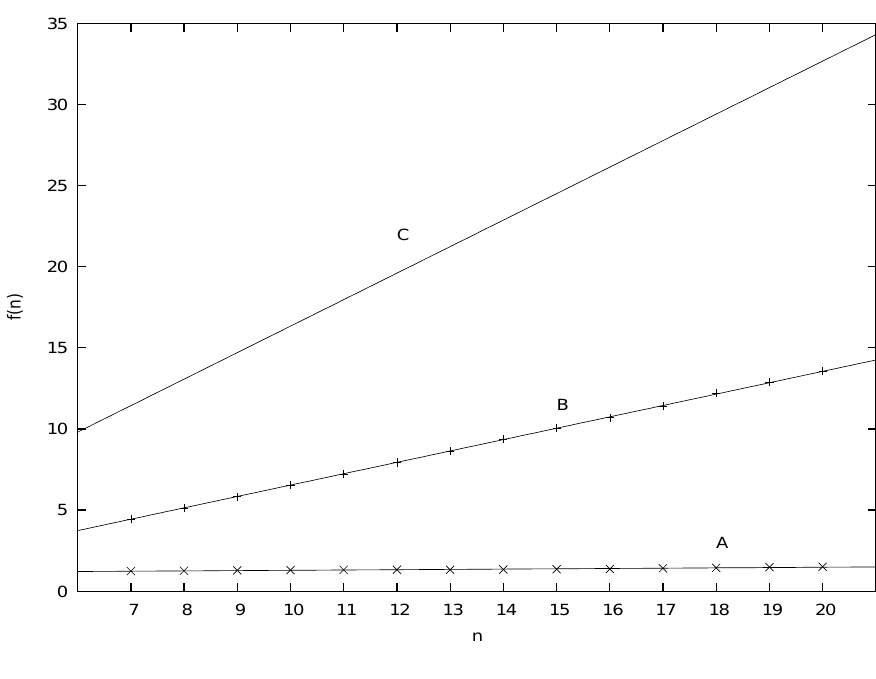
Figure 2. The linear relations for the three